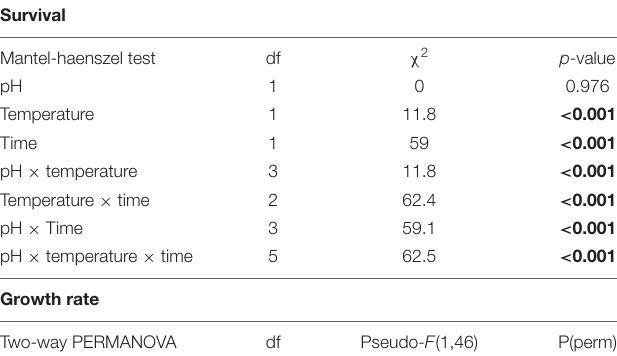
TABLE 2 | Summary of statistical analyses on Favites colemani physiological response under pH-temperature treatments for 28 days.